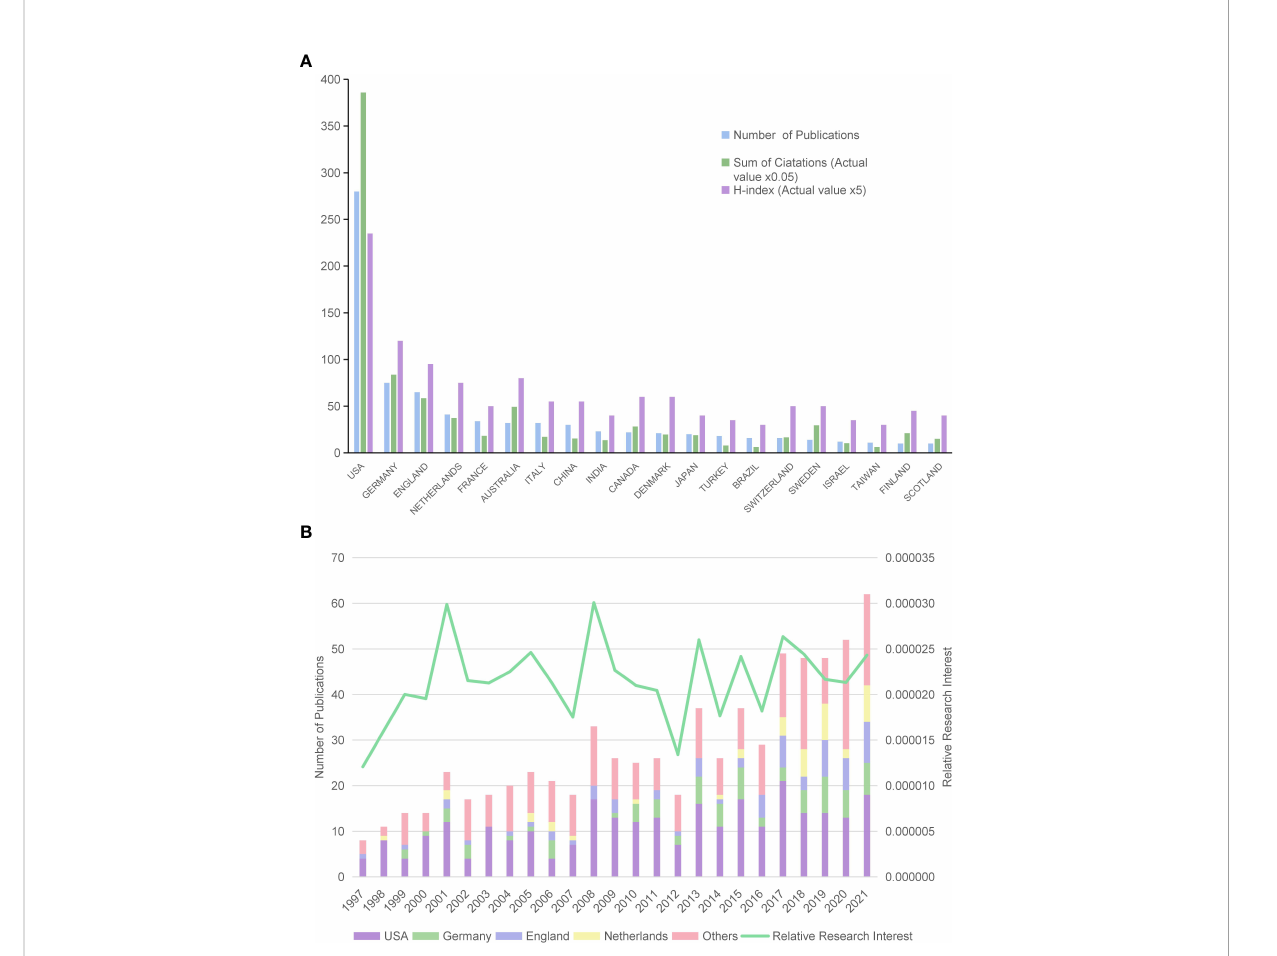
FIGURE 2 Contributions to the CM research of different countries/regions. (A) The number of publications, citations (×0.05), and H-index value (×5) of the top 20 countries or regions; (B) histogram shows the amount of publications worldwide and the top four countries. Line chart shows the time course of